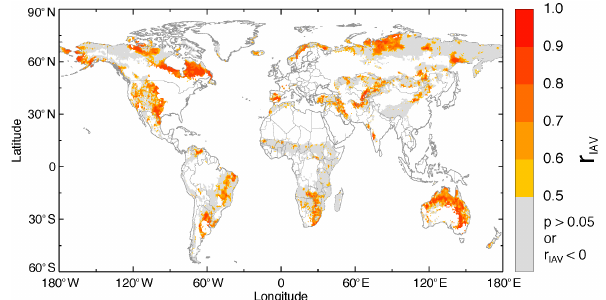
Figure 9. Spatial distribution of r IAV between MODIS-GPP and GPP model . r IAV is the correlation coefficient between detrended time series of modelled and MODIS-GPP from 2000 to 2012. This figure only shows the r IAV for grid cells with grassland covering more than 20% of total land in the MOD12Q1 dataset. Grey indi- cates insignificant or negative r IAV ( p> 0 . 05 or r IAV < 0); yellow- to-red indicates significant positive r IAV with increasing value ( r IAV > 0 and p< 0 .